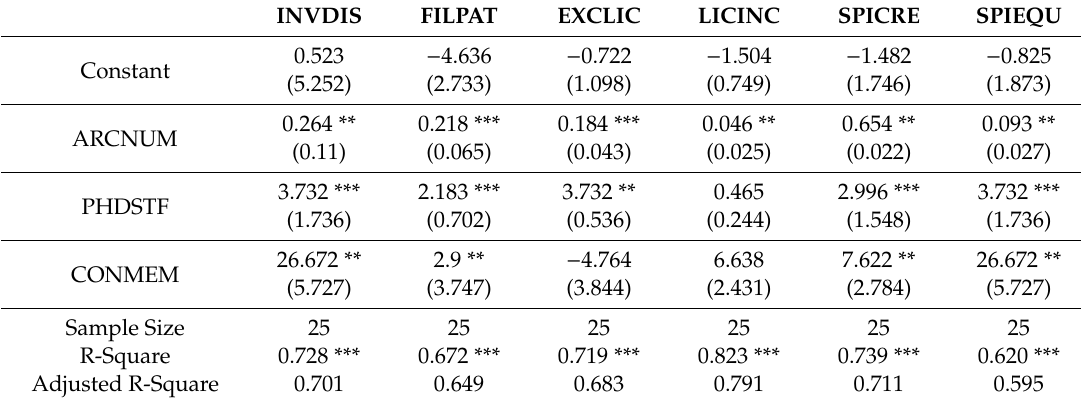
Table 6. Multiple regression analysis